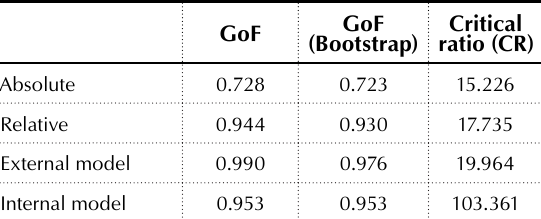
Table 8. Model’s linear quality